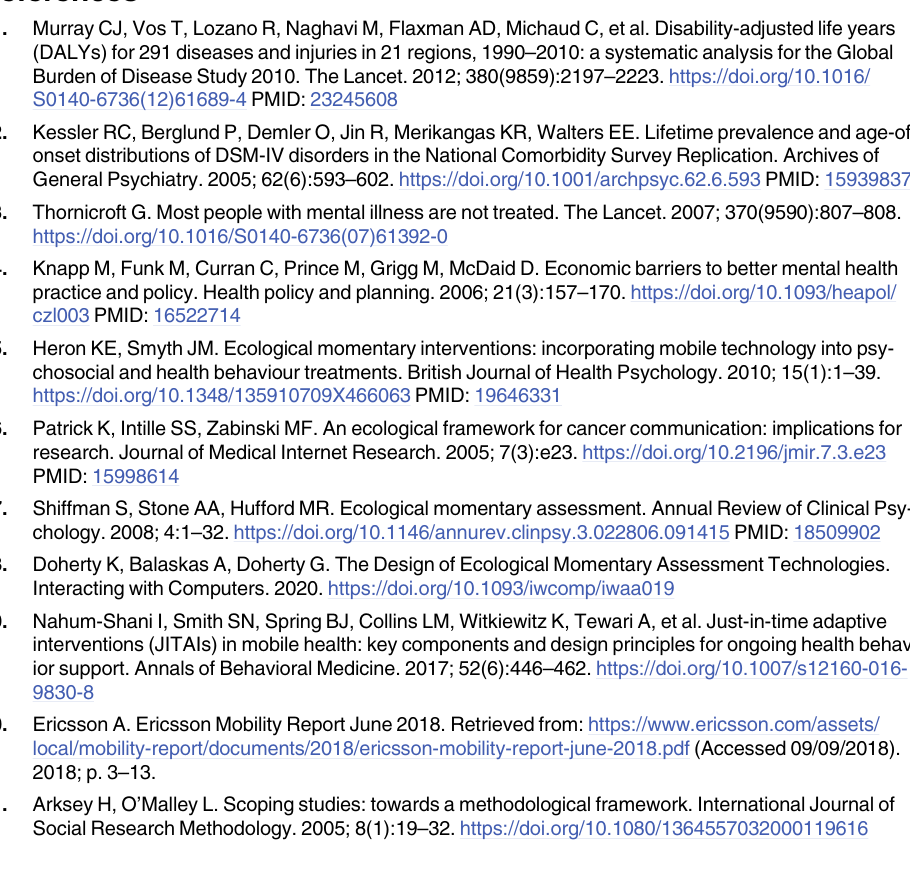
S2 Table. List of included papers. S3 Table. Characteristics of ecological momentary interventions. S4 Table. List of studies using sensors. S5 Table. Studies using sensors to predict/detect psychological